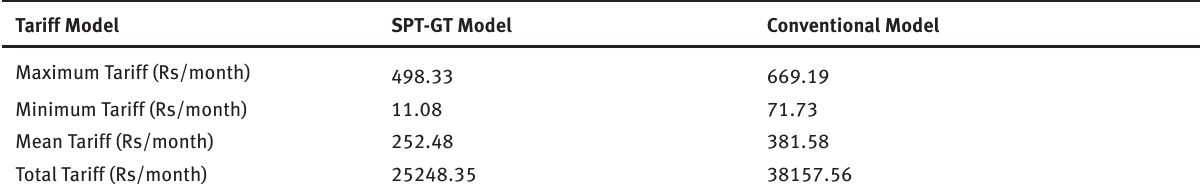
Table 2: Comparative study of SPT-GT model and conventional model of energy tariff Tariff Model